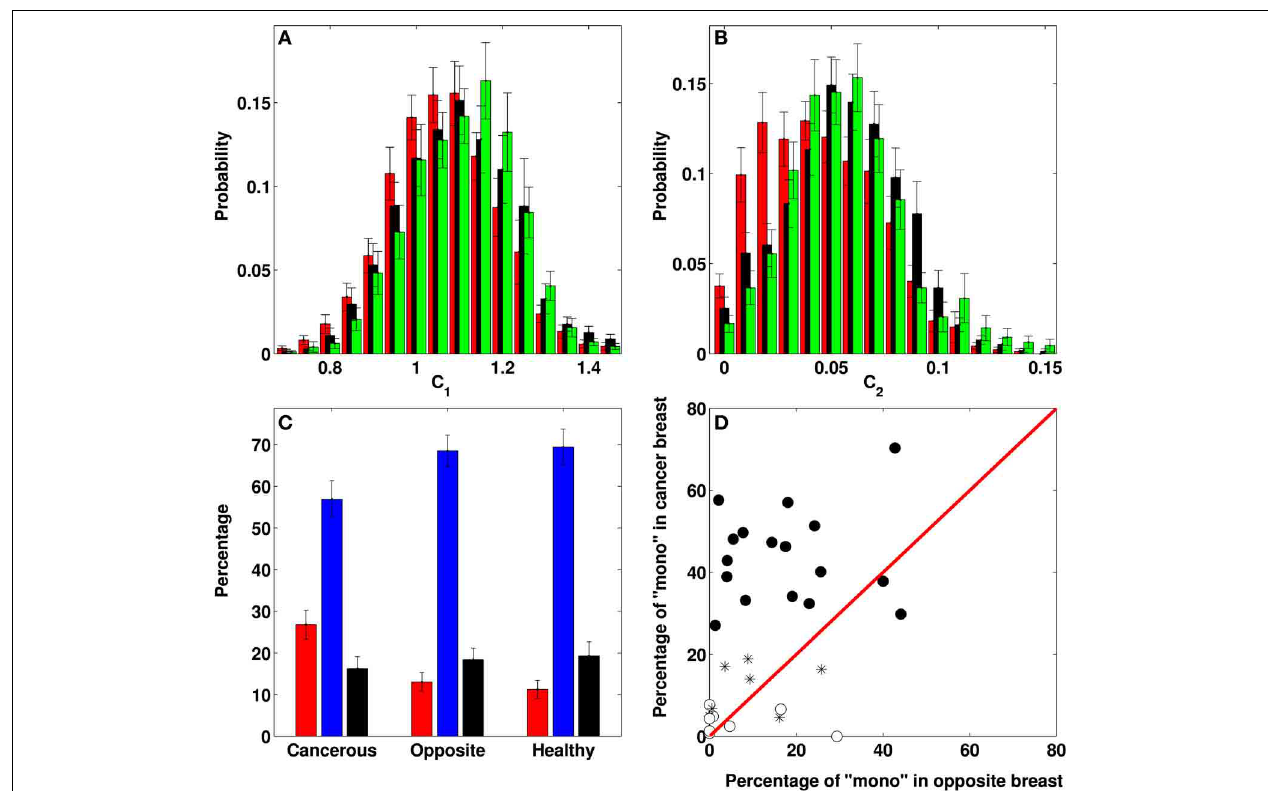
opposite breast of each patient; the symbols have the following meaning: ( • ) 17 patients with a percentage of monofractal squares on the cancerous breast larger than the mean value 26.8%, namely patients 2, 4, 7, 8, 9, 10, 11, 13, 17, 19, 20, 22, 25, 26, 29, 30, and 32 (patient 6 is not taken into account because of mastectomy of right breast); ( ∗ ) 7 patients with the percentage of monofractal squares on the cancerous breast smaller than 26.8% but well localized on the tumor region, namely patients 3 (16.3%), 14 (18.9%), 21 (14.0%), 23 (4.6%), 24 (4.9%), 31 (6.8%), and 33 (17.0%); ( ◦ ) 8 false negatives, namely patients 1 (2.4%), 5 (0.8%), 12 (4.9%), 15 (1.3%), 16 (0.0%), 18 (7.7%), 27 (4.3%), and 28 (6.6%) (see Table 2